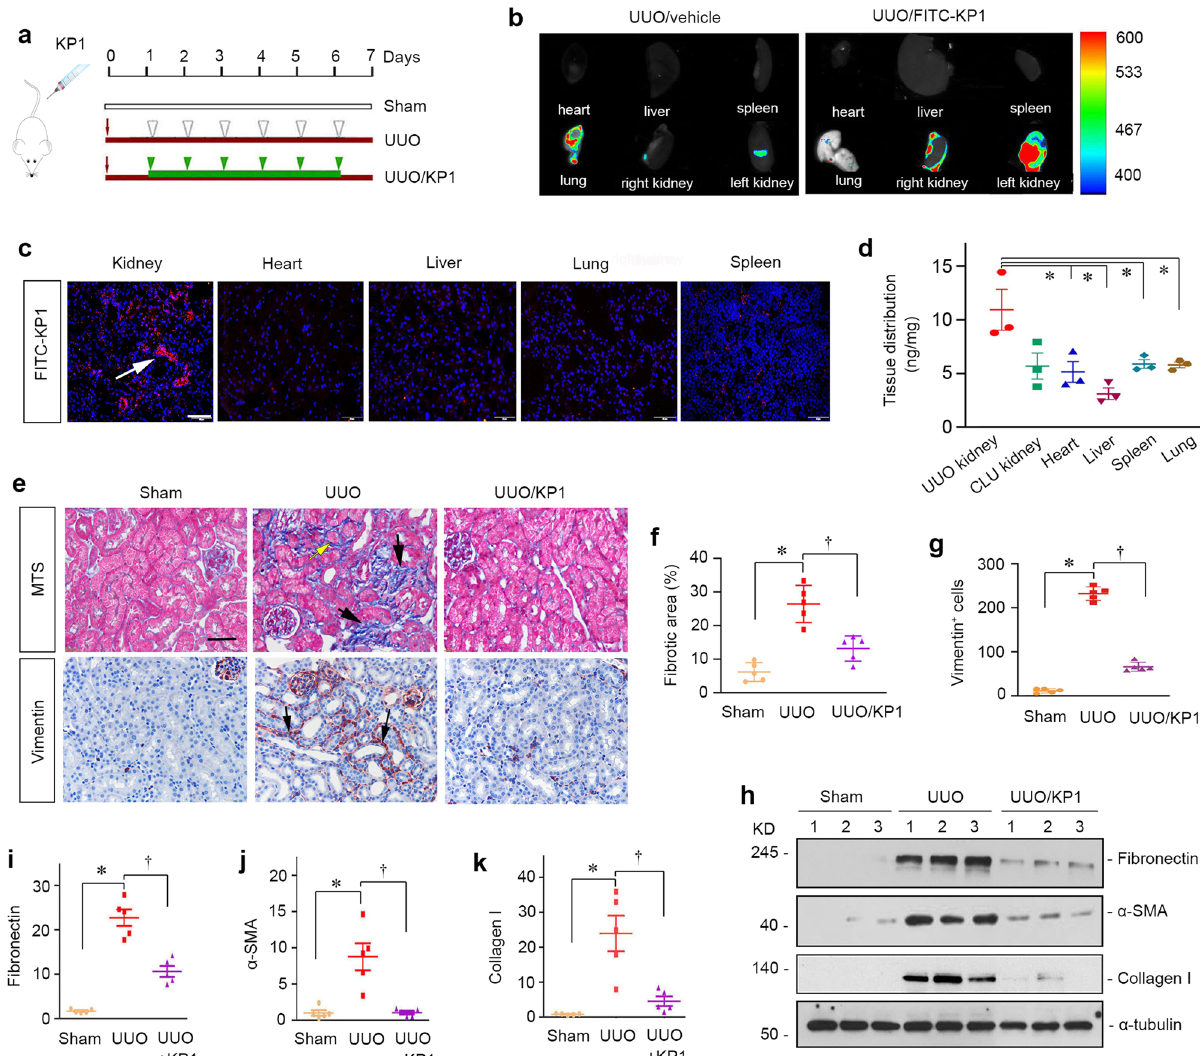
Fig. 6 KP1 attenuates renal fi brosis in obstructive nephropathy. a Experimental design. The green arrowheads indicate the injections of KP1 (1 mg/kg body weight), whereas the white arrowheads indicate the injections of vehicle (0.01 M acetic acid). b The organ distribution of FITC-KP1 in vivo. Major organs as indicated were assessed for FITC-KP1 accumulation at 0.5 h after intravenous injection. c Representative micrographs of immuno fl uorescence of FITC-KP1 in organs. UUO mice were sacri fi ced 0.5 h after intravenous injection of FITC-KP1. Tissue cryosections were stained with an anti-FITC antibody. Kidney indicates UUO injured kidney. Scale bar, 50 µ m. d The concentration of KP1 in each organ was assessed by LC – MS/MS at 0.5 h after intravenous injection. Two-sided t test P values (from left to right): 0.041, 0.014, 0.049, 0.049. n = 3 biologically independent animals. e Representative micrographs of Masson ’ s trichrome staining and immunohistochemical staining for vimentin showed that KP1 decreased interstitial matrix deposition and myo fi broblasts activation. Arrows indicate positive staining. Scale bar, 50 µ m. f , g Quantitative data of Masson ’ s trichrome staining and vimentin-positive cells number. P values: < 0.001, < 0.001 (Masson); < 0.001, < 0.001 (vimentin). n = 5 biologically independent animals. h – k Representative Western blot ( h ) showed renal expression of fi bronectin, α -SMA, and collagen I in different groups. Quantitative data of renal fi bronectin ( i ), α -SMA ( j ), and collagen I ( k ). P values (from left to right): 0.001, 0.001 ( fi bronectin); 0.033, 0.035 ( α -SMA);0.026, 0.043 (collagen I). n = 5 biologically independent animals. Data are presented as mean values ± SEM. P values were determined by one-way ANOVA with Fisher ’ s LSD post hoc test in ( f , g ) or one-way ANOVA with Dunnett ’ s T3 test in ( i – k ). Source data are provided as a Source Data fi